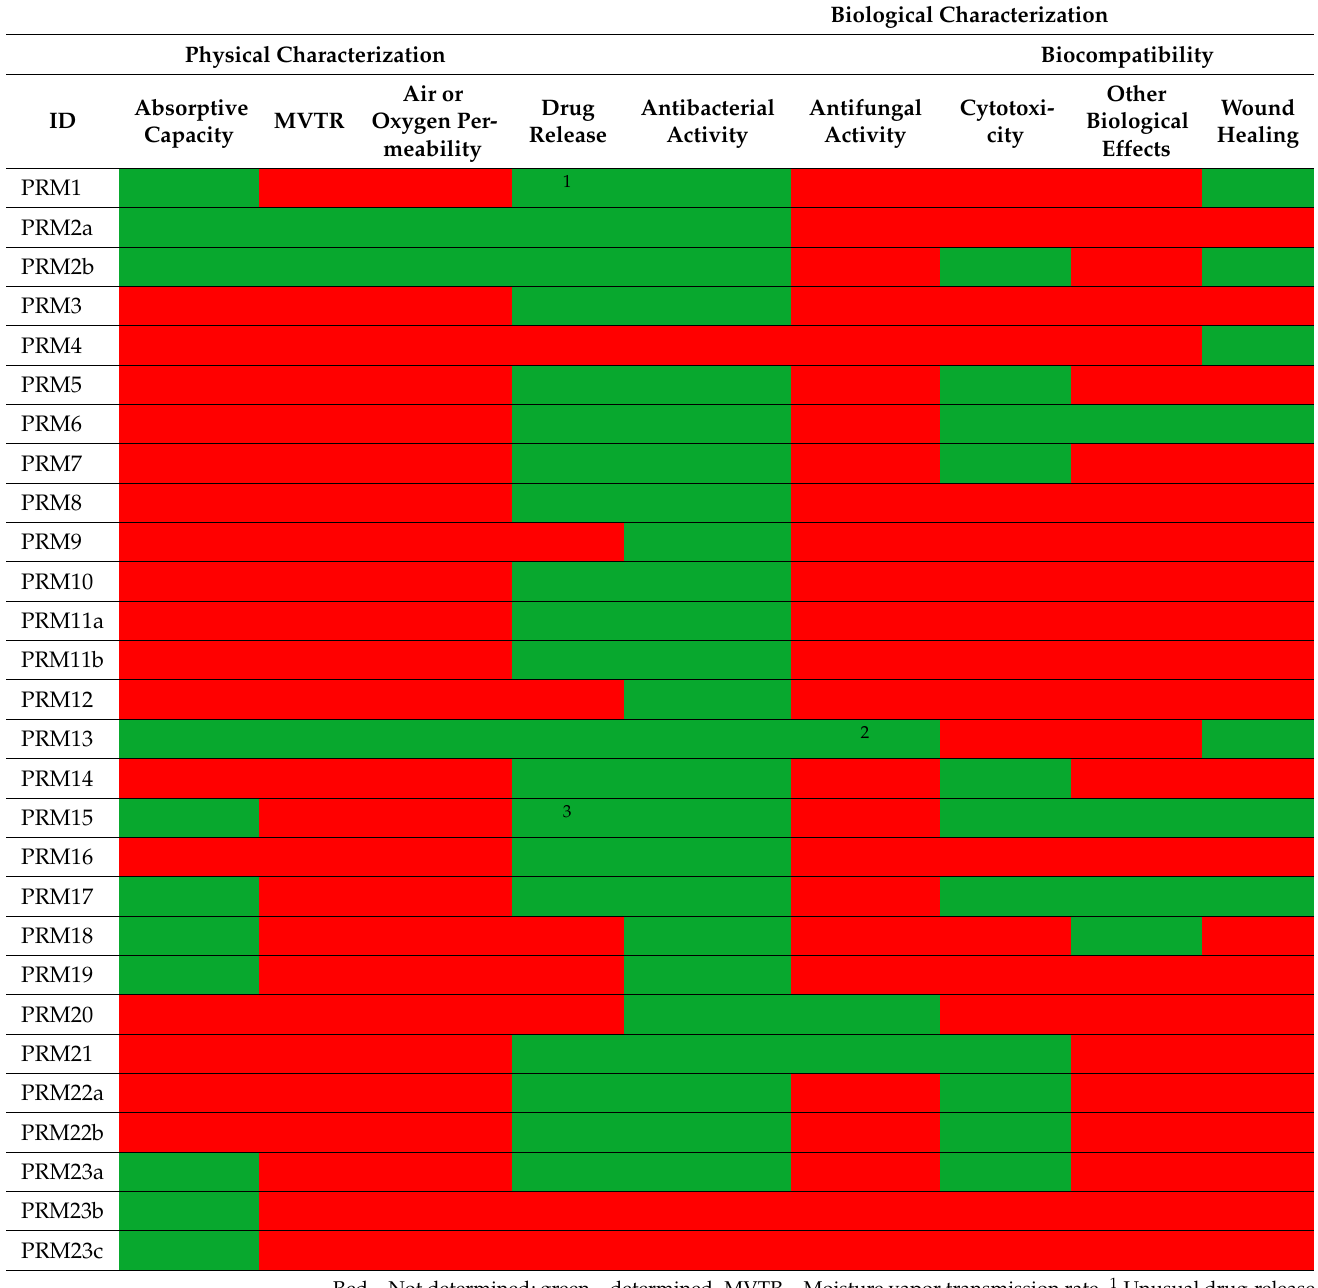
Table 4. Overview of the studies carried out with PHMB-releasing membranes (PRMs) developed for antimicrobial dressings (AMDs). Membrane IDs and corresponding bibliographic references are the same as in Table